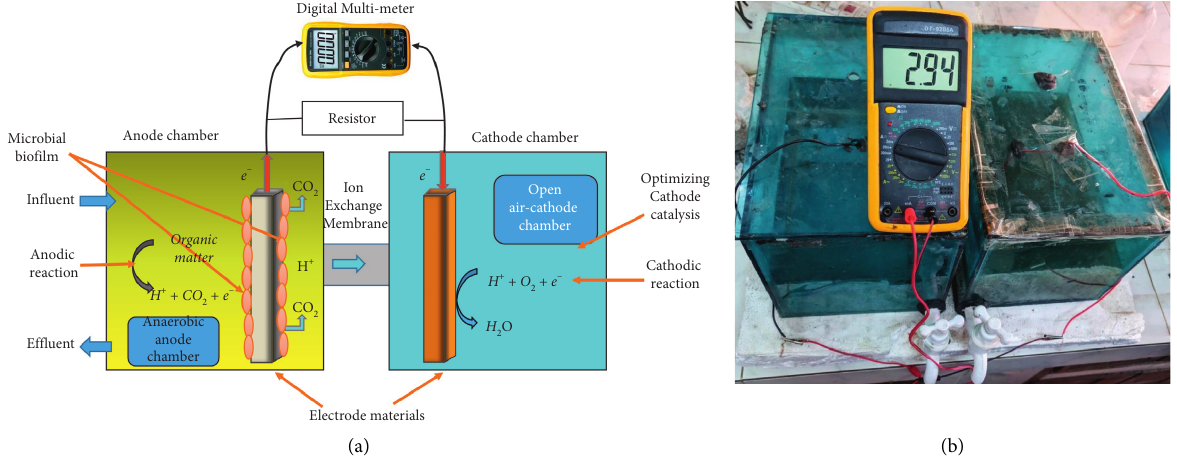
Figure 1: (a) Schematic presentation and (b) experimental setup of the double-chamber MFC.